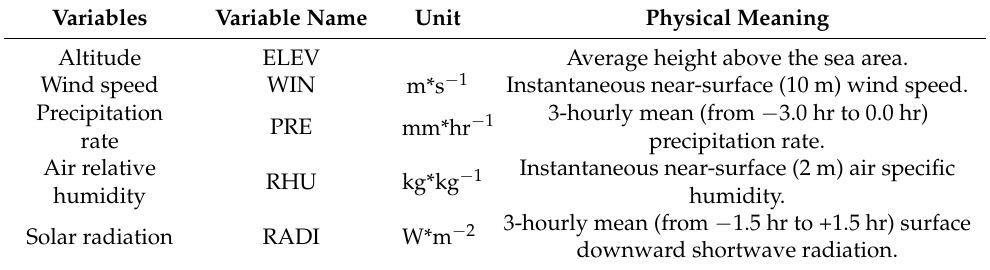
Figure 2. Schematic diagram of the mechanism of urban form and natural factors affecting the heat island effect. Table 1. Natural indicators used.